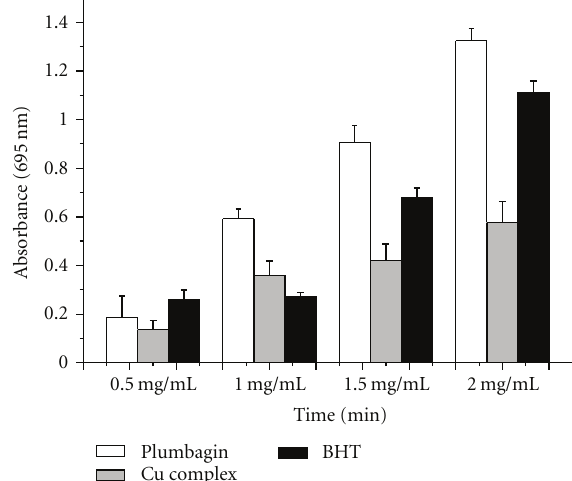
Figure 1: DPPH free radical scavenging activity of plumbagin, Cu (II) complex, and BHT in di ff erent reaction times (10, 20, 30, 40, 50, and 60min).